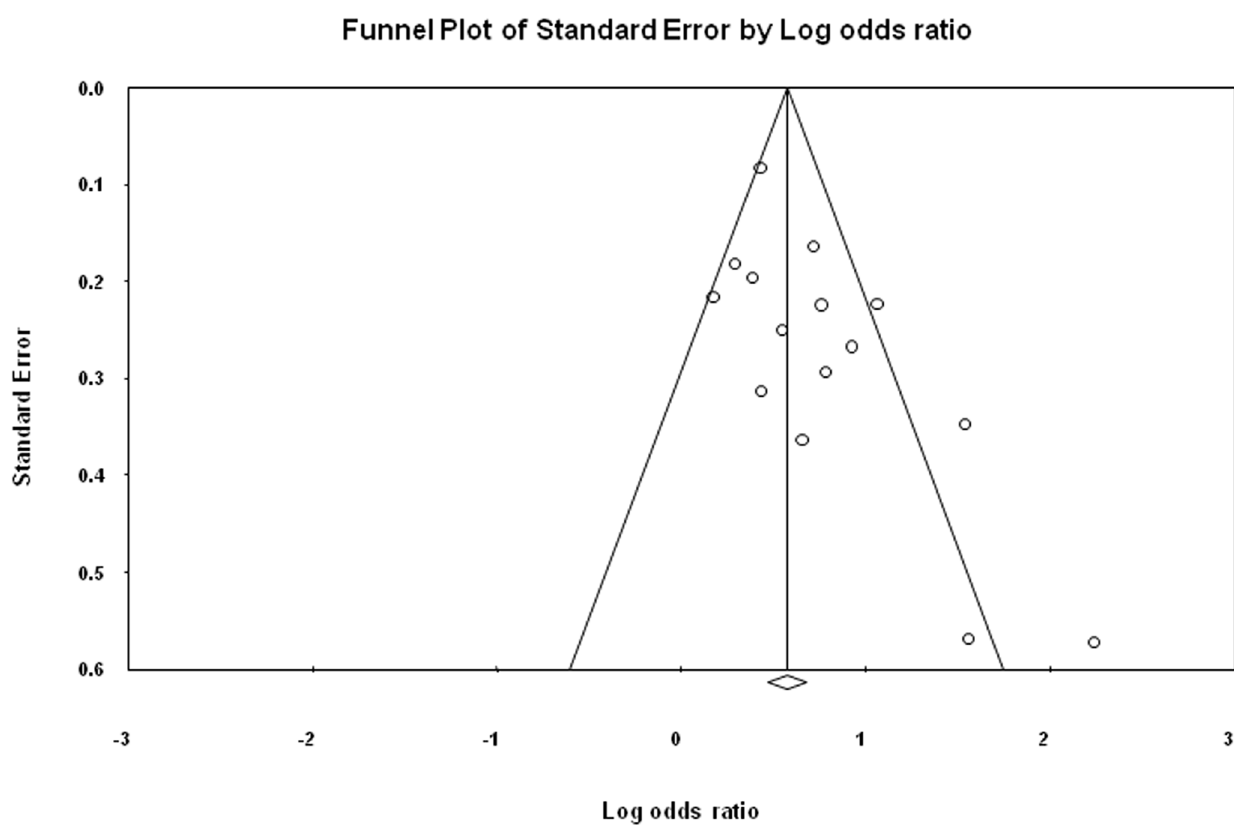
Figure 6. Publication bias for case-control studies illustrating the relationship between BQ without tobacco and incidence of oral cancer.